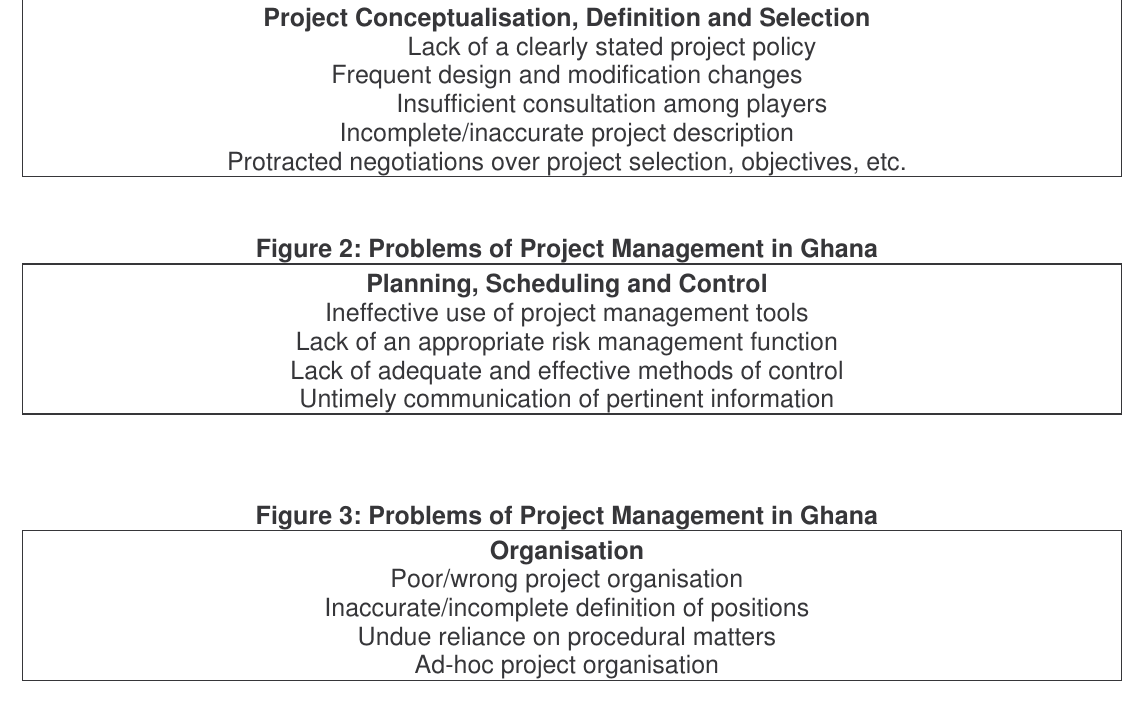
Figure 1: Problems of Project Management in Ghana